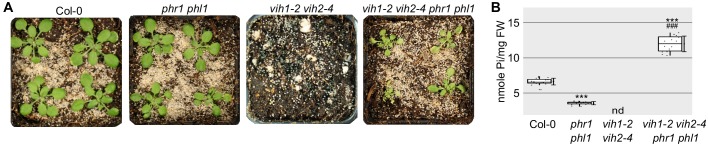
Growth phenotypes of soil-grown phr1 phl1, vih1-2 vih2-4 and vih1-2 vih2-4 phr1 phl1 mutant adult plants.(A) Growth phenotype of phr1 phl1, vih1-2 vih2-4, and vih1-2 vih2-4 phr1 phl1 mutant plants in comparison to the Col-0 control. Seedlings 7 DAG were transferred to soil and grown for 21 d. (B) Shoot Pi content of plants 20 DAG as described in (A). Four independent plants were measured with two technical replicates each.